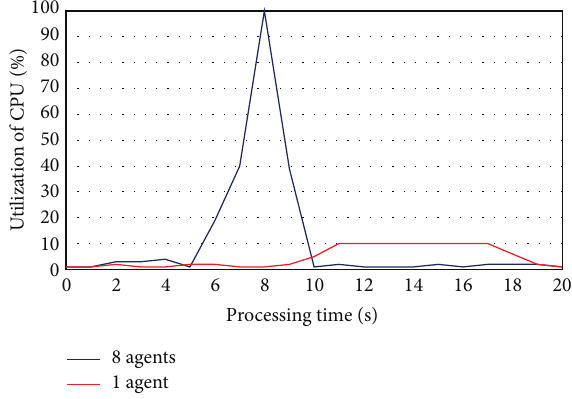
Figure 10: Time required to process the testing datasets in relation to the number of computers.